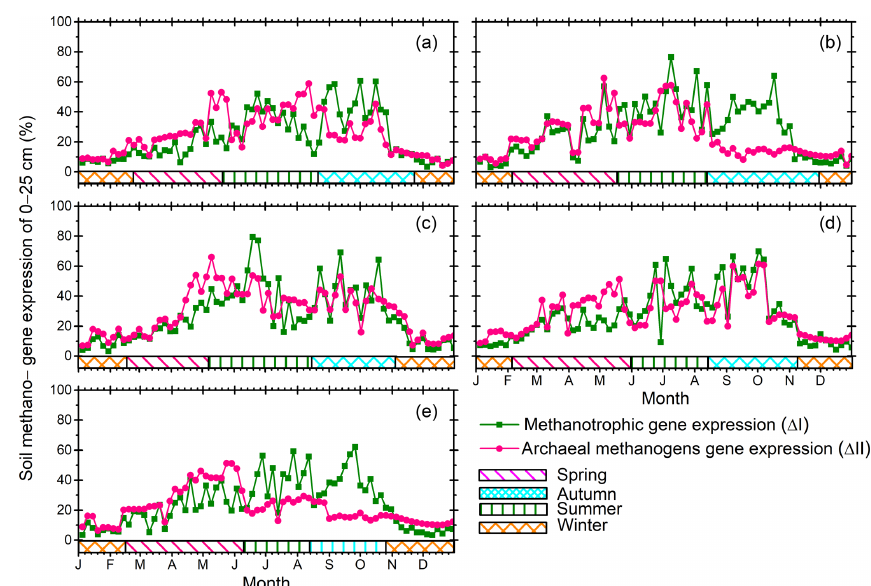
Figure 2. Annual patterns of soil methanogen gene expression of 0–25cm soil depth for the years (a) 2012, (b) 2013, (c) 2014, (d) 2015, and (e)